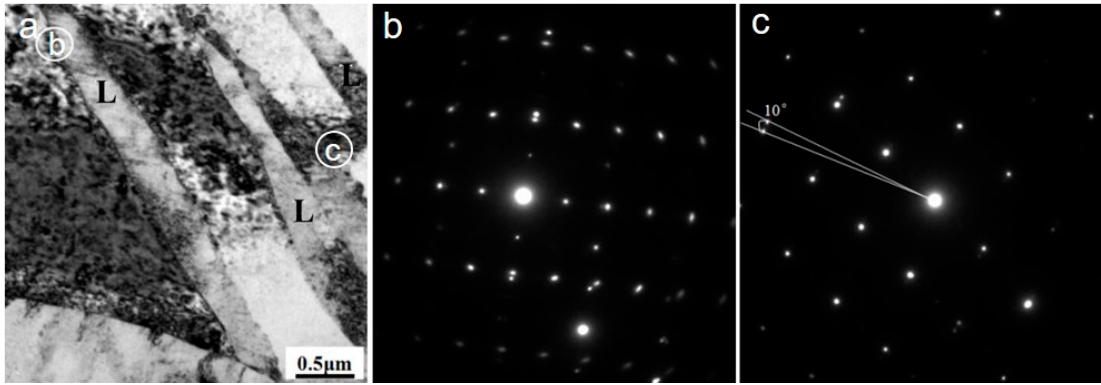
Figure 2. Transmission electron microscopy (TEM) images of sample F-12. ( a ) bright field image; ( b ) selected diffraction pattern of region “b” in ( a ); ( c ) selected diffraction pattern of region “c” in ( a ).